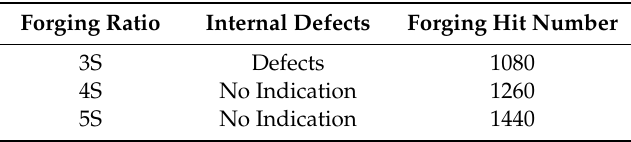
Table 6. Result of the round bar forging.